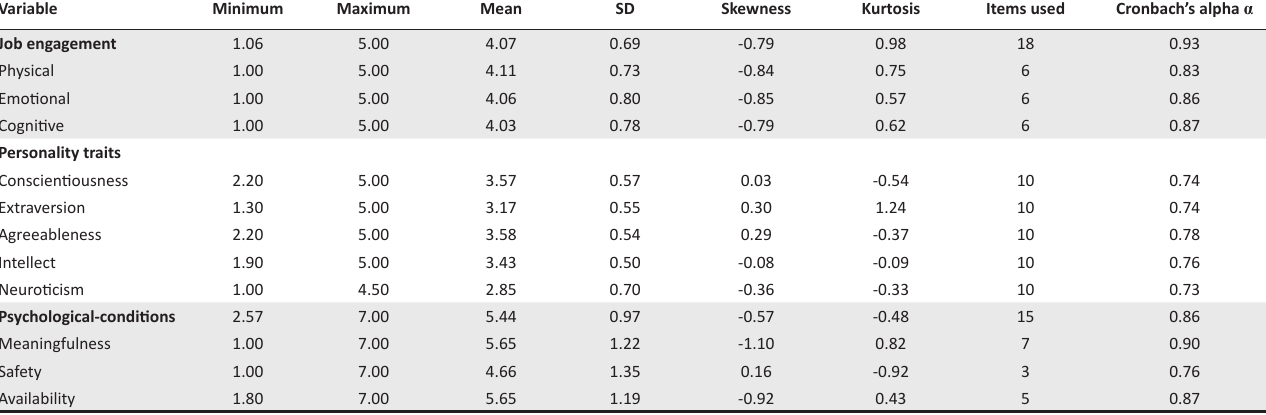
TABLE 1 : Summary of descriptive statistics of main variables and reliability analysis using the Cronbach’s alpha coefficient.